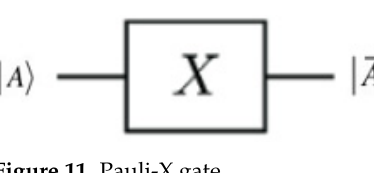
Figure 11. Pauli-X gate.